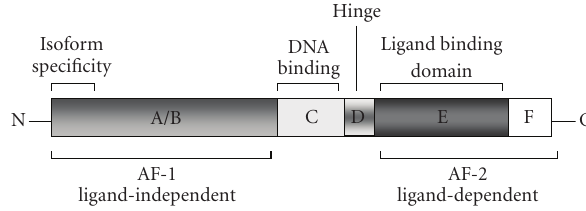
Figure 1: Structural organization of the functional domains of nu- clear